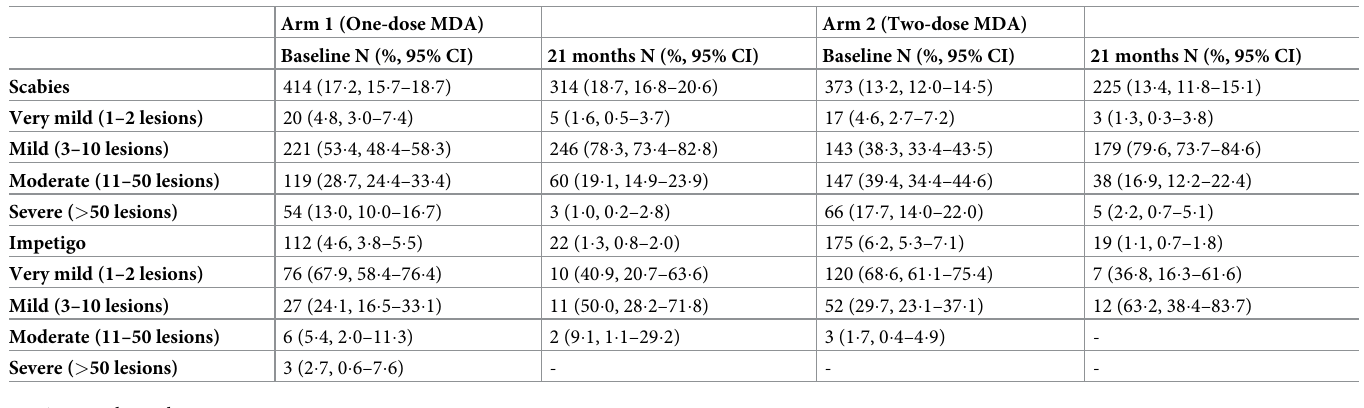
Table 2. Scabies and impetigo prevalence and severity at baseline and at 21 months after mass drug administration. Arm 1 (One-dose MDA) Arm 2 (Two-dose MDA) Baseline N (%, 95% CI) 21 months N (%, 95% CI) Baseline N (%, 95%